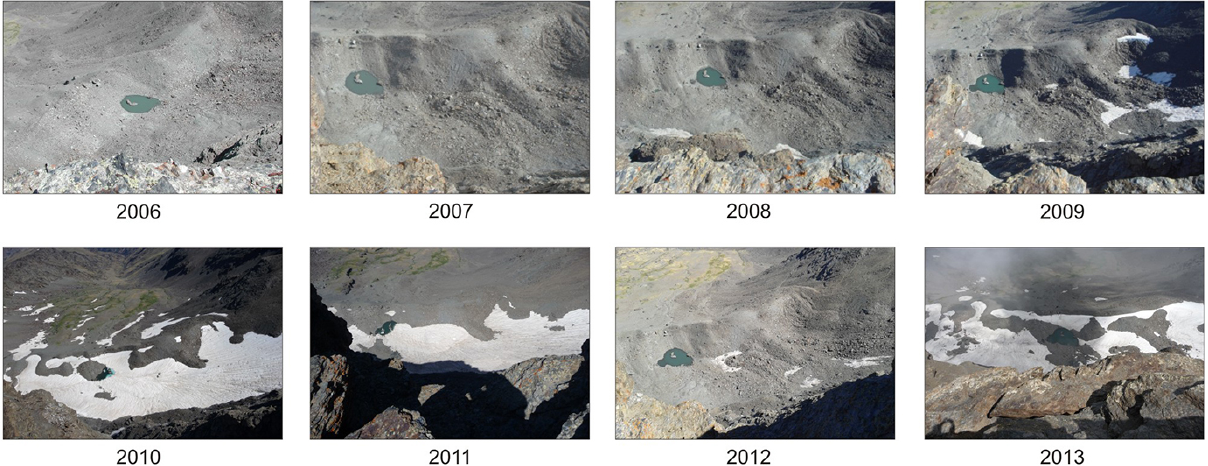
Figure 3. Vertical photographs of snow cover on the Corral del Veleta at the end of August from 2006 to 2013.